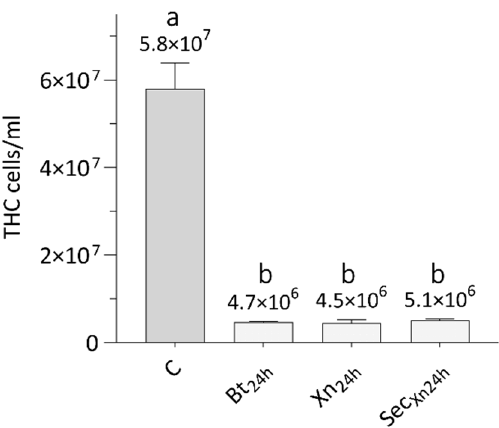
Figure 8. Total hemocytes extracted from naive larvae (C), from larvae treated with B. thuringiensis (Bt 24h ), X. nematophila (Xn 24h ) and X. nematophila secretions (Sec Xn24h ), 24 h after administration. THC: total hemocytes count. Letters (a–b) indicate significant differences in the pairwise comparisons (Tukey test, p < 0.05).